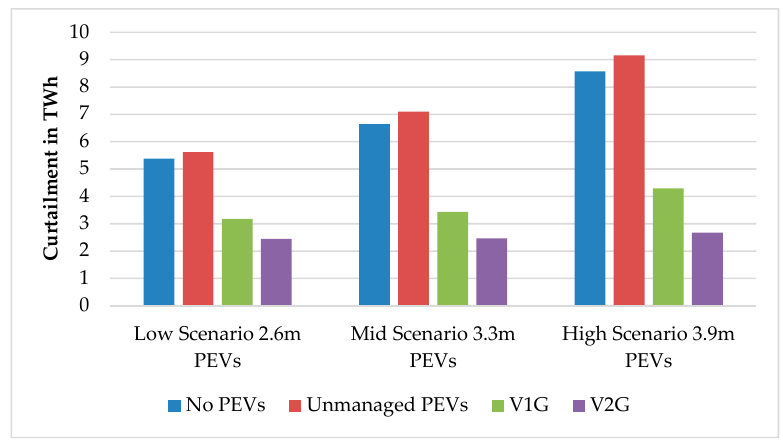
Figure 6. Curtailment in California 2030 with the influence of PEVs.